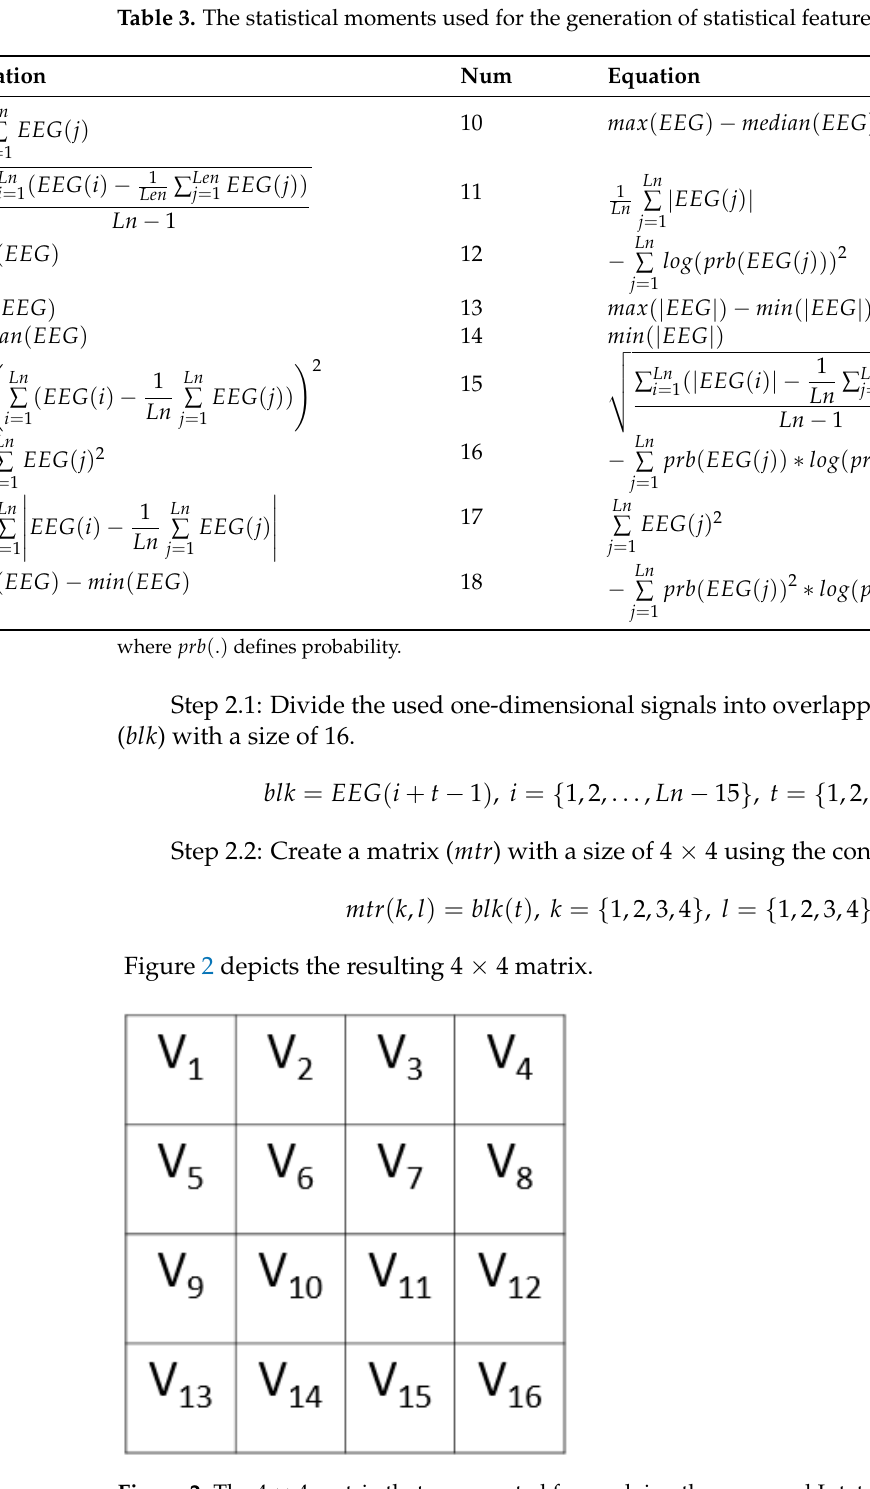
Figure 2. The 4 × 4 matrix that was created for applying the proposed L-tetrolet pattern. Step 2.3: Use two L-tetrolet based patterns by employing the 4 × 4 sized